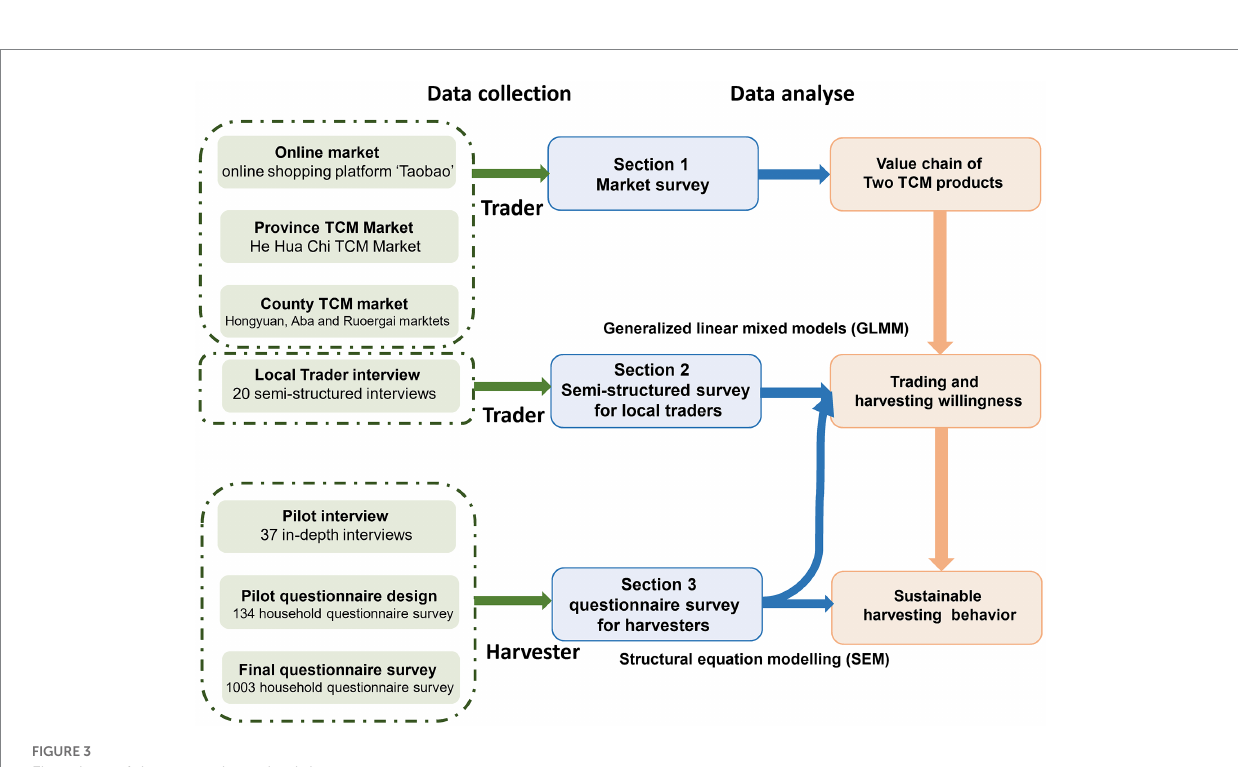
FIGURE 3 Flowchart of the research